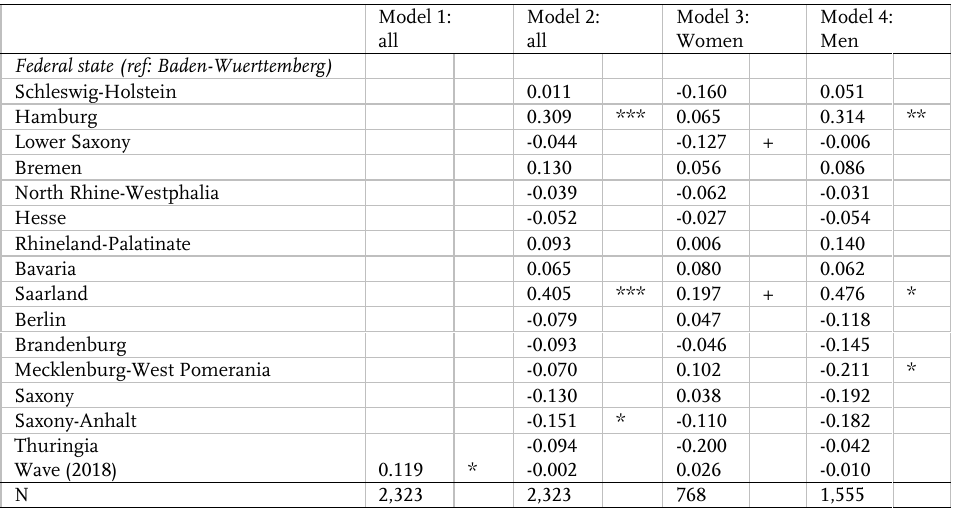
Table A.4 : Results from logistic regression (1: Employed; 0: Not employed), pooled models and models by gender, average marginal effects (AME) (continued)